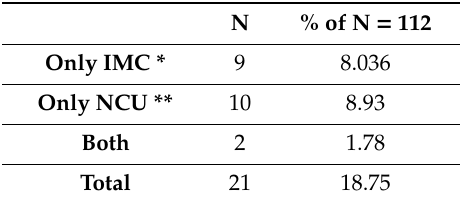
Table 6. Frequencies of patients with new symptoms.